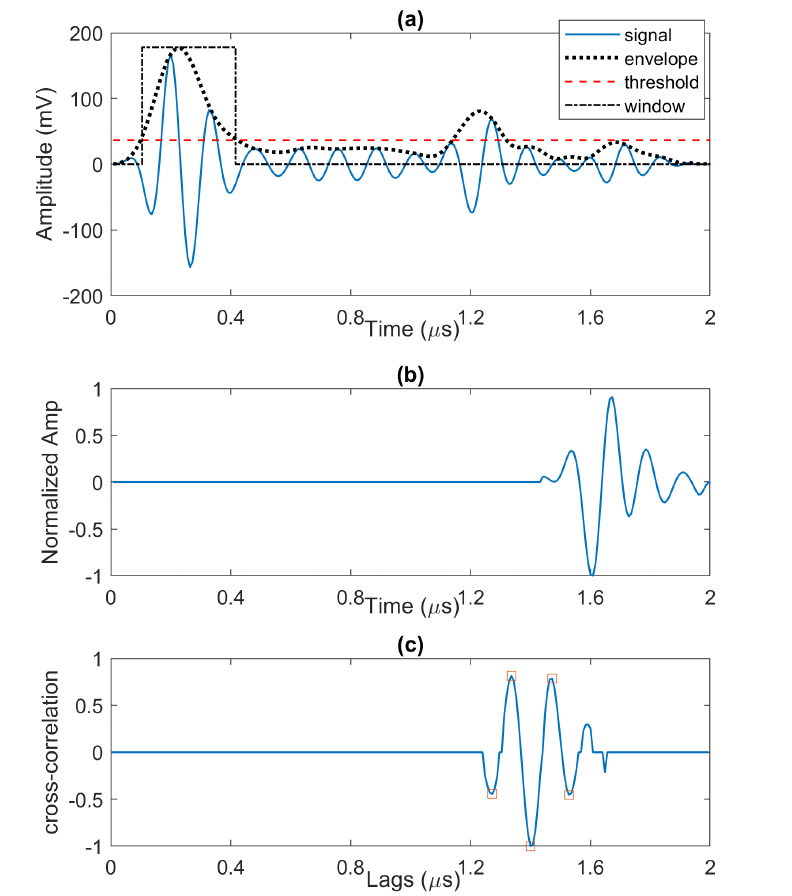
Figure 7. ( a ) Full wave A-scan with its envelope, threshold, and a window showing the area where envelope is above the threshold, ( b ) reference echo model, and ( c ) cross-correlation between the windowed signal and the reference model. A few largest peaks (based on absolute value of cross-correlation) are shown with red